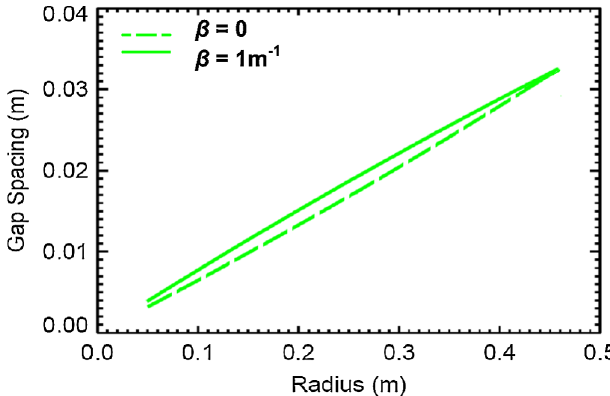
FIG. 2. (Color) The A-K gap spacing as a function of radius for a radial disk MITL, plotted for 0 : 05 m (cid:9) r (cid:9) 0 : 46 m . The induc- tance of the load is 51.2 nH; the maximum gap spacing is 32.6 mm and is located at the edge of the anode disk ( r ¼ 0 : 46 m ). The bottom curve represents the curvature of the anode which corresponds to a radially constant electron flow